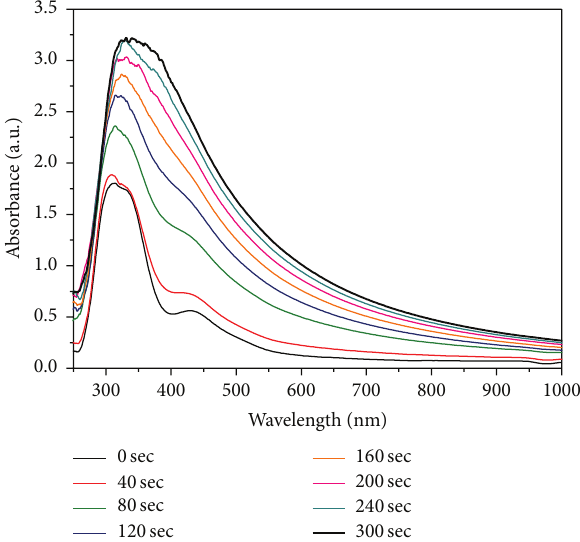
Figure 5: UV-Vis absorption spectra at different reaction times during the reduction of [PdCl 4 ] 2− at 90 ∘ C.